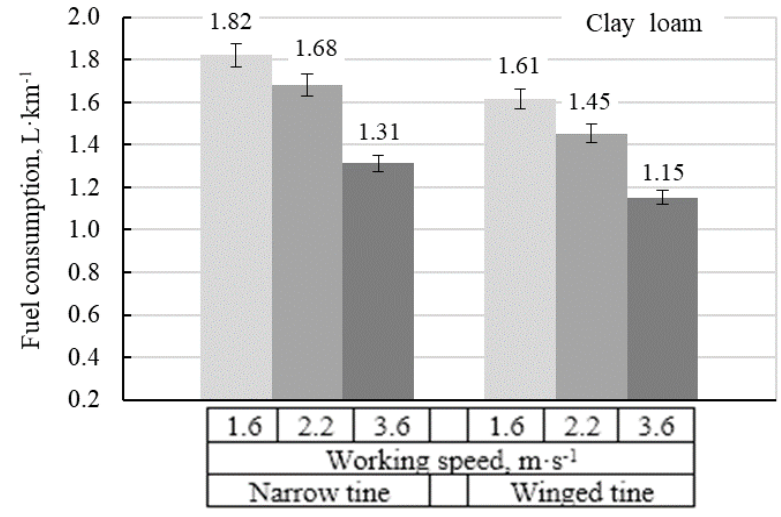
Figure 13. Dependence of fuel consumption on speed and tine types clay loam soil.